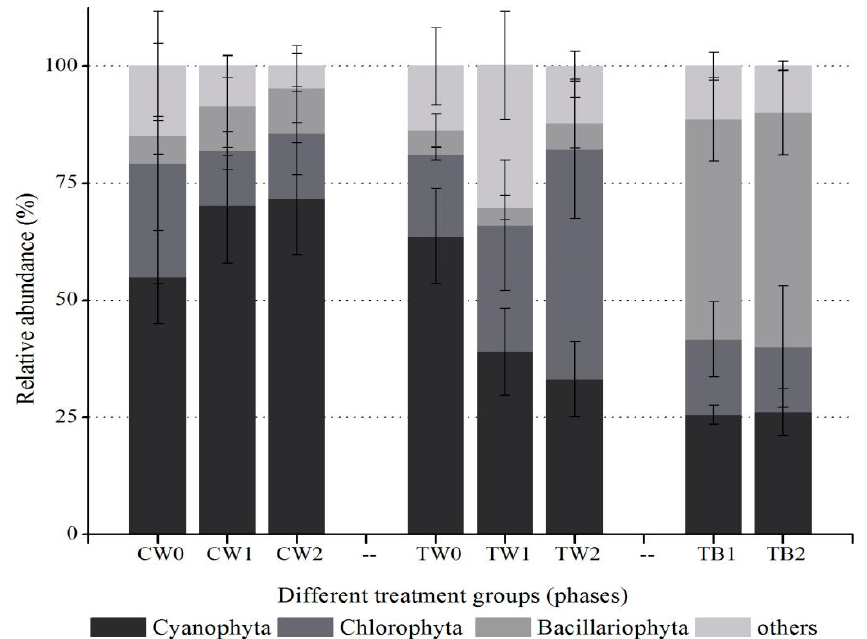
Figure 5. Variation of structural composition of phytoplankton in the enclosure.